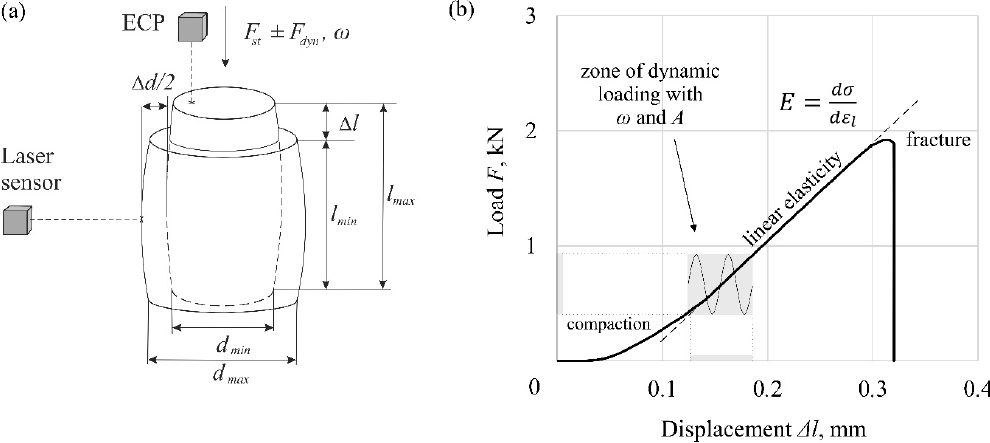
Figure 2. Experimental conditions: ( a ) schematics of rock sample deformation during the experiment; ( b ) stress state of a sample during dynamic loading.